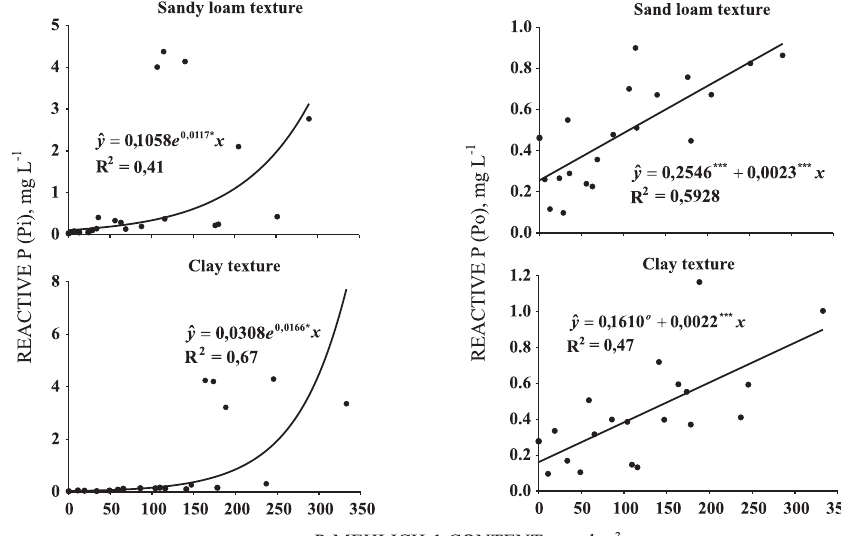
Figure 6. Variation in P reactive (Pi) and P non-reactive (Po) contents in the leachates according to the P contents extracted by Mehlich-1 in the top ring (0–10 cm) in two soil samples of Latosols of sandy loam and clay texture, prefertilized with increasing mineral P rates corresponding to the percentages of Maximum Phosphorus Adsorption Capacity (MPAC), as influenced by the application of increasing poultry litter rates. *, ***: significant at 5 and 0.1 %, respectively.